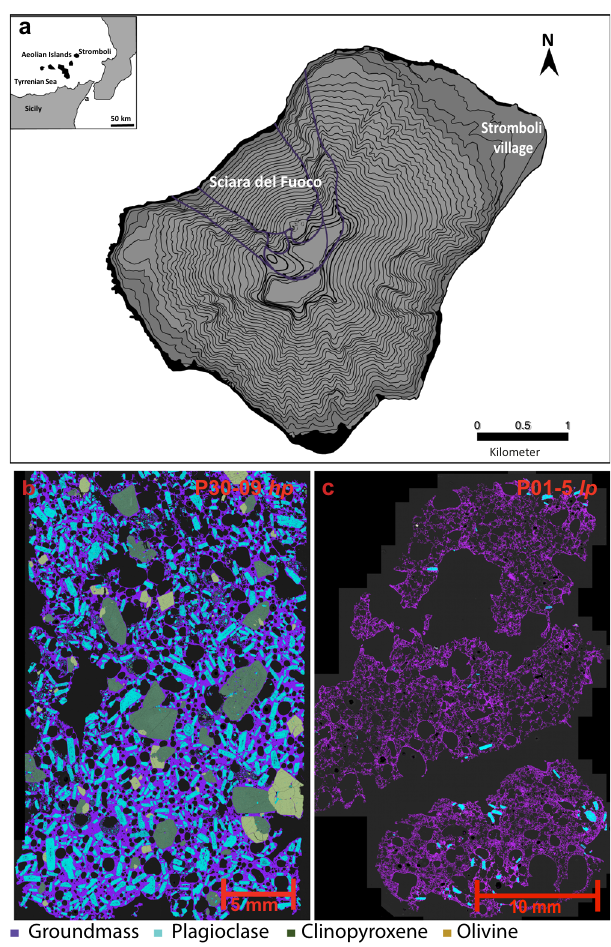
Fig.1 |MapofStrombolivolcanoandmineralogicalmapof2019tephra.a Map ofStrombolivolcanowithitslocationinrespecttoSouthernItalyshownintheinset. Mineralogical maps with colour-coded mineral phases of 2019 hp ( b ) and lp ( c ) tephra from the 3 July (samples P30-09 hp and P01-5 lp ) paroxysmal events. Typical hp blackscoriaewithhigh-porphyriticseriatetextures(~45 – 50vol%),lowvesicularity (~10 – 20 vol.%) and microlite-rich glassy groundmass have erupted during normal Strombolian activity, major explosions, and paroxysmal events. Light lp pumices characterised by weakly porphyritic seriate textures (<10 vol.% phenocrysts and microphenocrysts), high vesicularity (~30 – 40 vol.%) and a glassy groundmass are erupted during paroxysmal events and less frequently during major explosions. Phenocrysts and microphenocrysts of plagioclase (~20 – 30 vol.% of the total crystal content), clinopyroxene (~10 – 15 vol.%) and minor olivine ( ≤ 5 vol.%) are present in both hp and lp tephra. However, the larger plagioclase phenocrysts visible in the lp pumice in c (cyan crystals), are derived by exchange from hp-